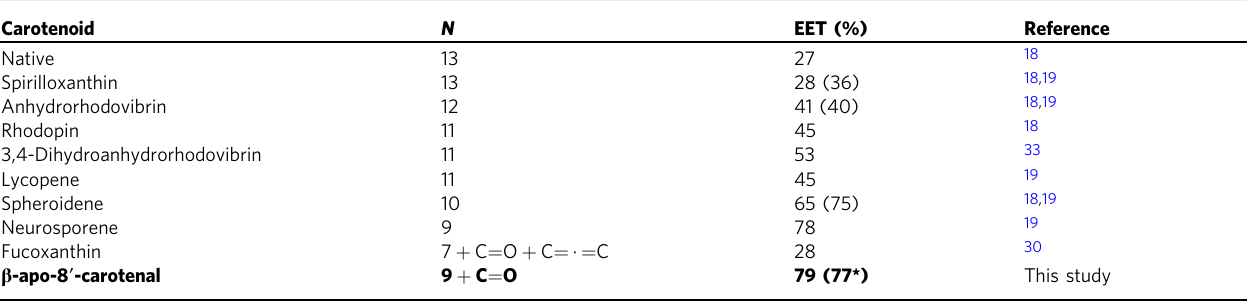
Table 1 Summary of the EET ef fi ciency from carotenoid to B880 Bchl a in the native and carotenoid-reconstituted LH1 from Rps. rubrum .